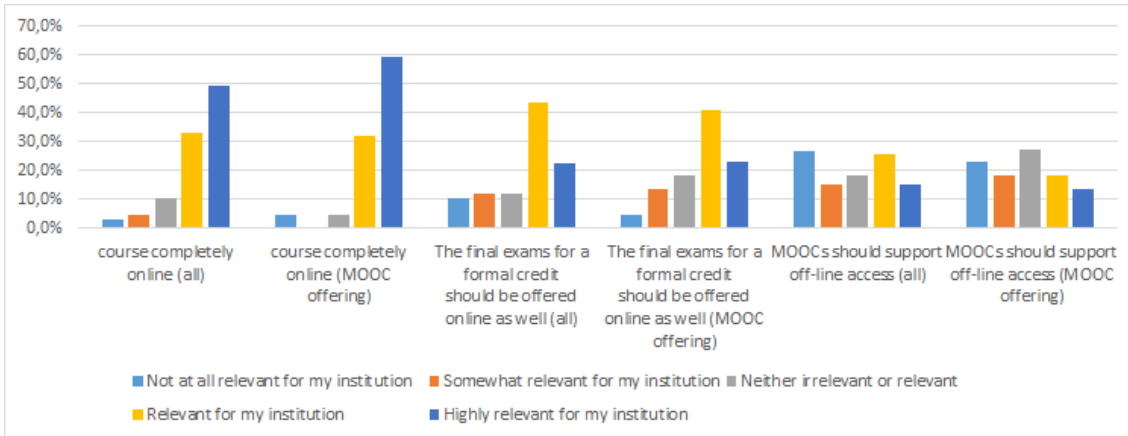
Figure 11. The importance of the online dimension in